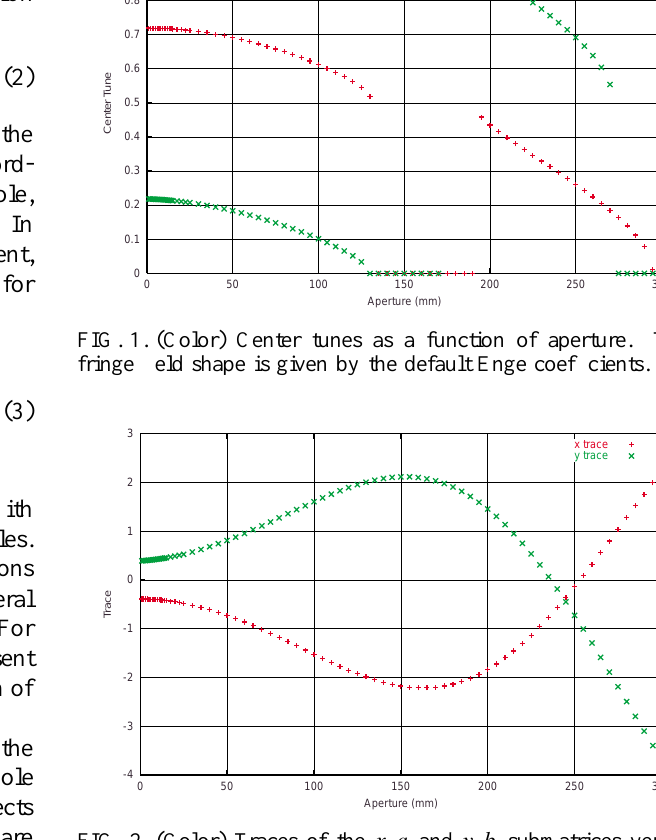
FIG. 2. (Color) Traces of the x - a and y - b submatrices versus aperture. The fringe field shape is given by the default Enge coefficients.